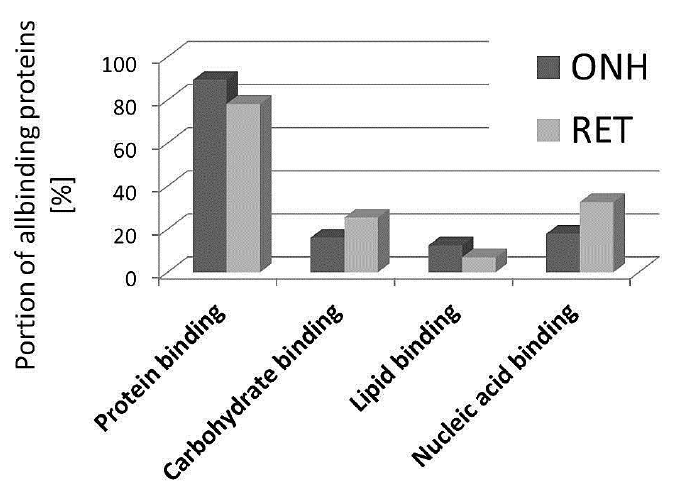
Student ’ s t -test).